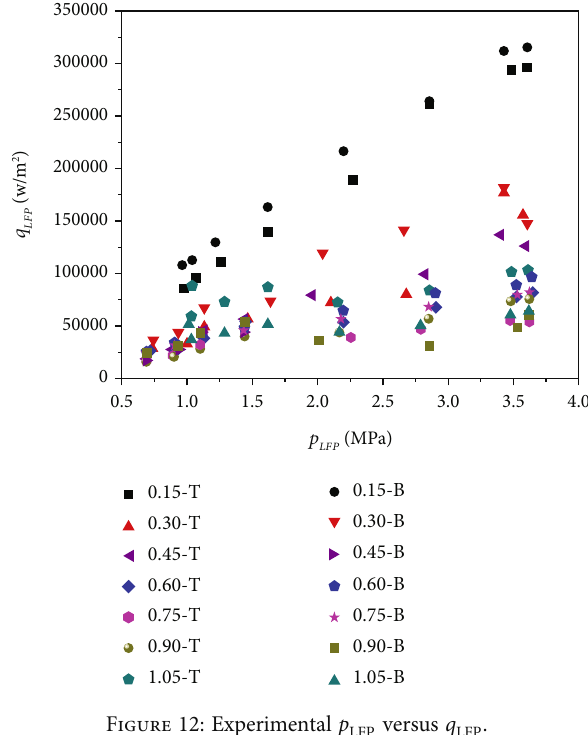
versus q . LFP LFP